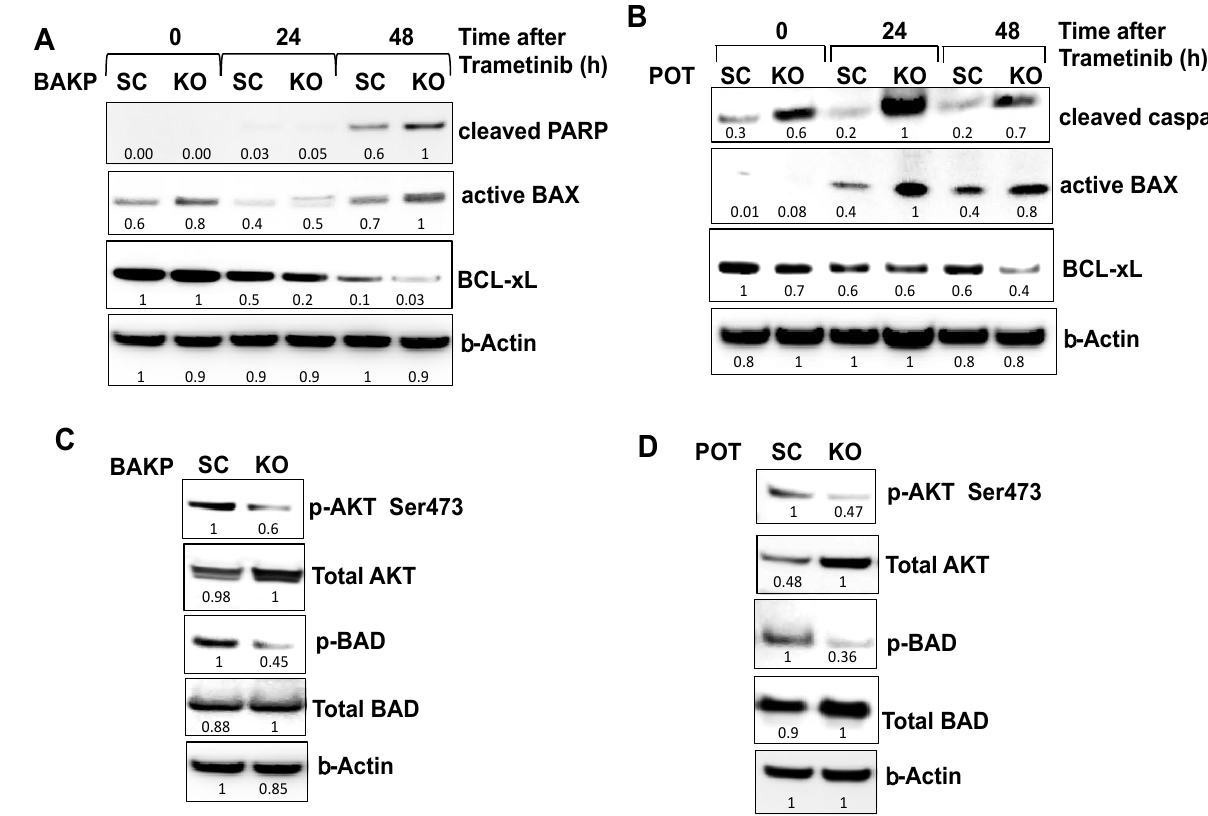
Figure 4. CRISPR-Cas9-mediated knockout of CD133 expression in BAKP ( A ) and POT ( B ) cells increases BAX activation, and PARP cleavage following trametinib treatment, sensitized by reduced basal levels of pro-survival BCL-xL, pAKT, and pBAD. ( A ) BAKP-KO, BAKP-SC cells, as well as ( B ) POT-SC and POT-KO cells were treated with 100 nM trametinib for 24 and 48 h, followed by immunoblot analysis with antibodies to cleaved PARP, cleaved active form of caspase-3, active BAX, BCL-xL, and β -actin as loading control. CD133 knockout in trametinib-exposed both BAKP-KO ( A ) and POT-KO ( B ) cells increases pro-apoptotic active BAX and decreases anti-apoptotic BCL-xL levels ( A,B ), sensitizing cells to apoptosis. Immunoblot analysis of pAKT, AKT, p-BAD, Bad, and β -actin as loading control in BAKP-KO ( C ) and POT-KO cells ( D ), compared to the SC controls. Densitometric analysis comparing intensities of protein bands relative to bands with the highest intensity is shown in immunoblots.